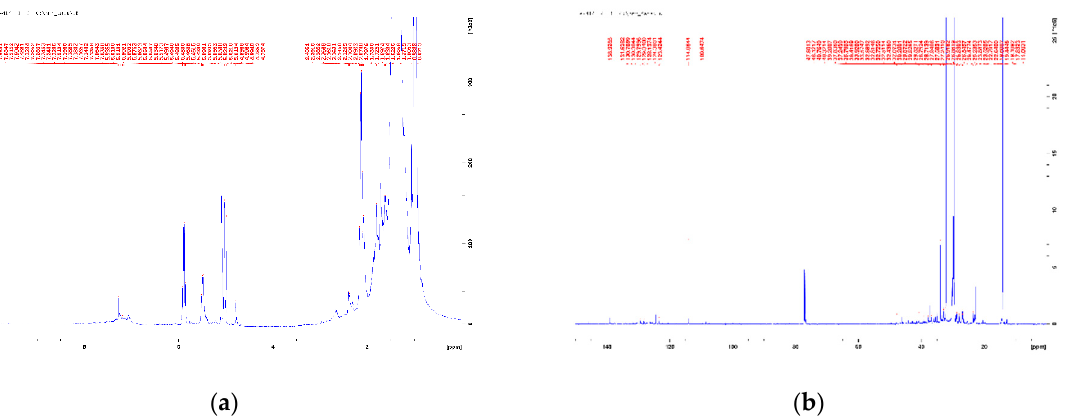
Figure 4. ( a ) 1 H NMR spectra and ( b ) 13 C NMR spectra of the blend Algae/HDPEwax 15/85.